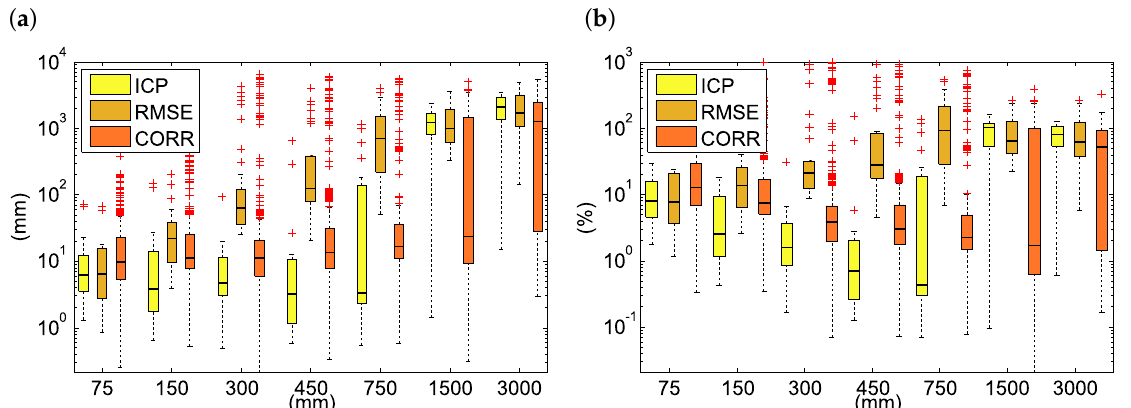
Figure 9. Absolute ( a ) and relative ( b ) translation errors of scan matching experiments for laser range scans taken after robot movement of